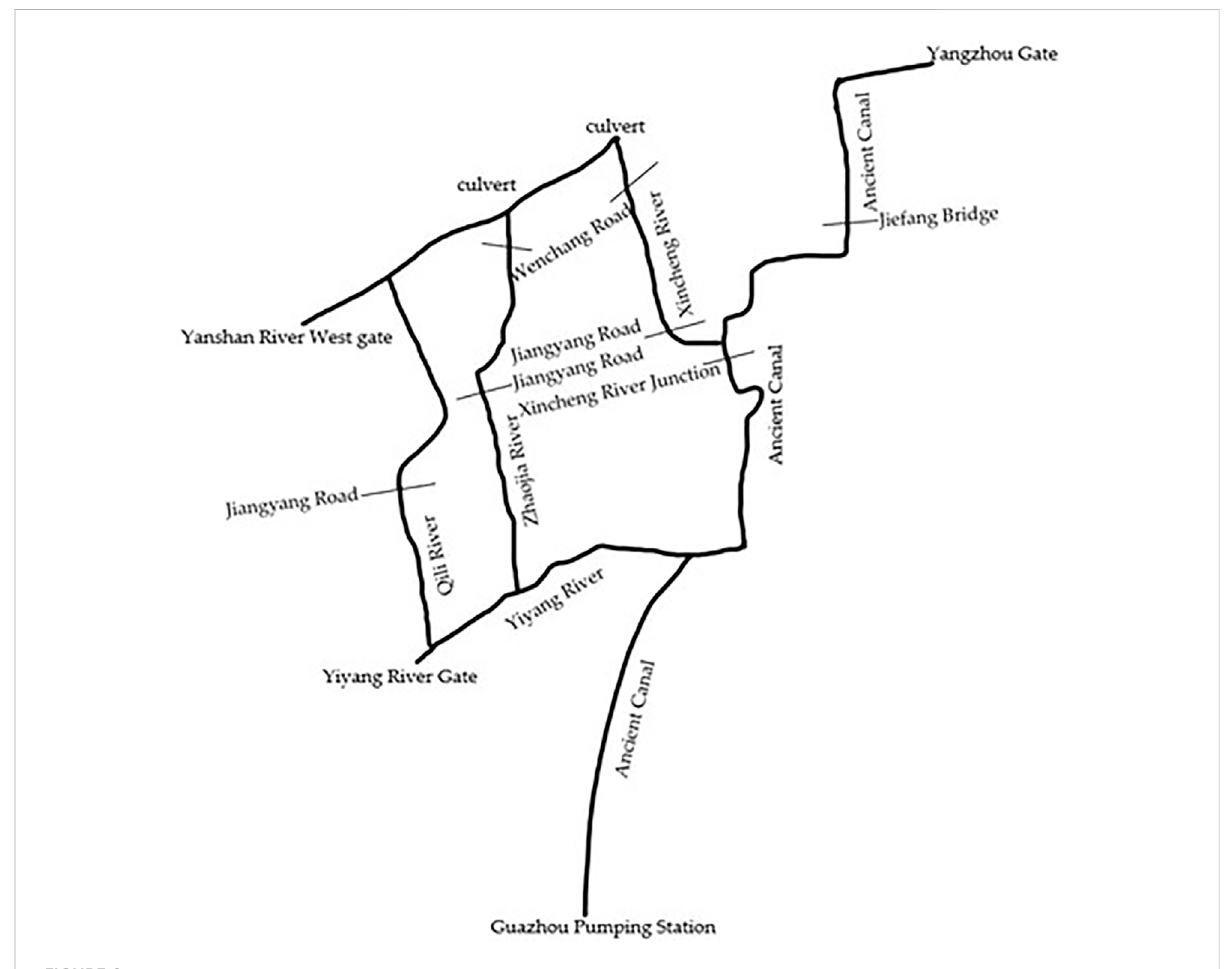
FIGURE 2 River network generalization of study